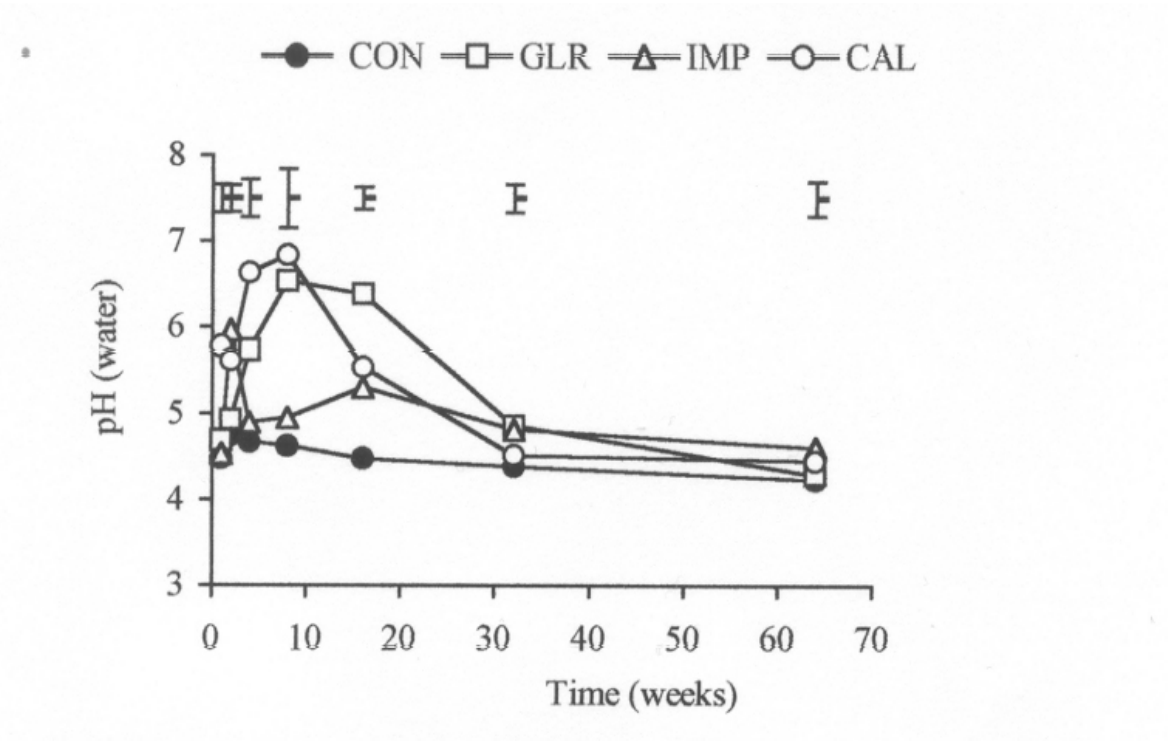
FIGURE 2. Changes in soil pH during incubation of a tropical soil treated with